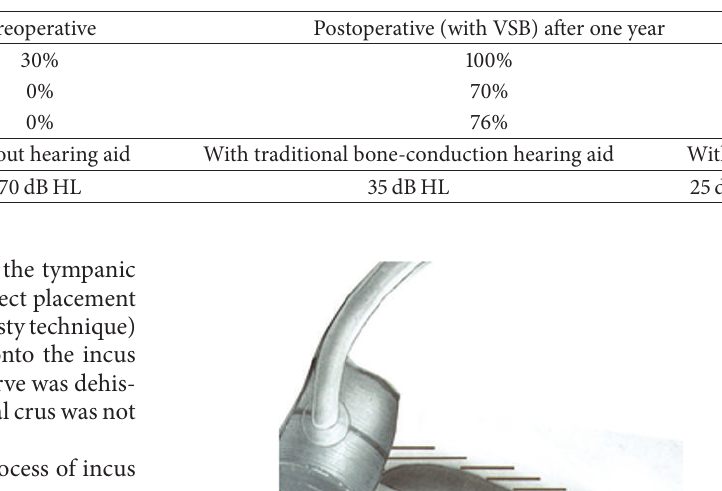
Table 1: Audiological evaluation before and after surgery.